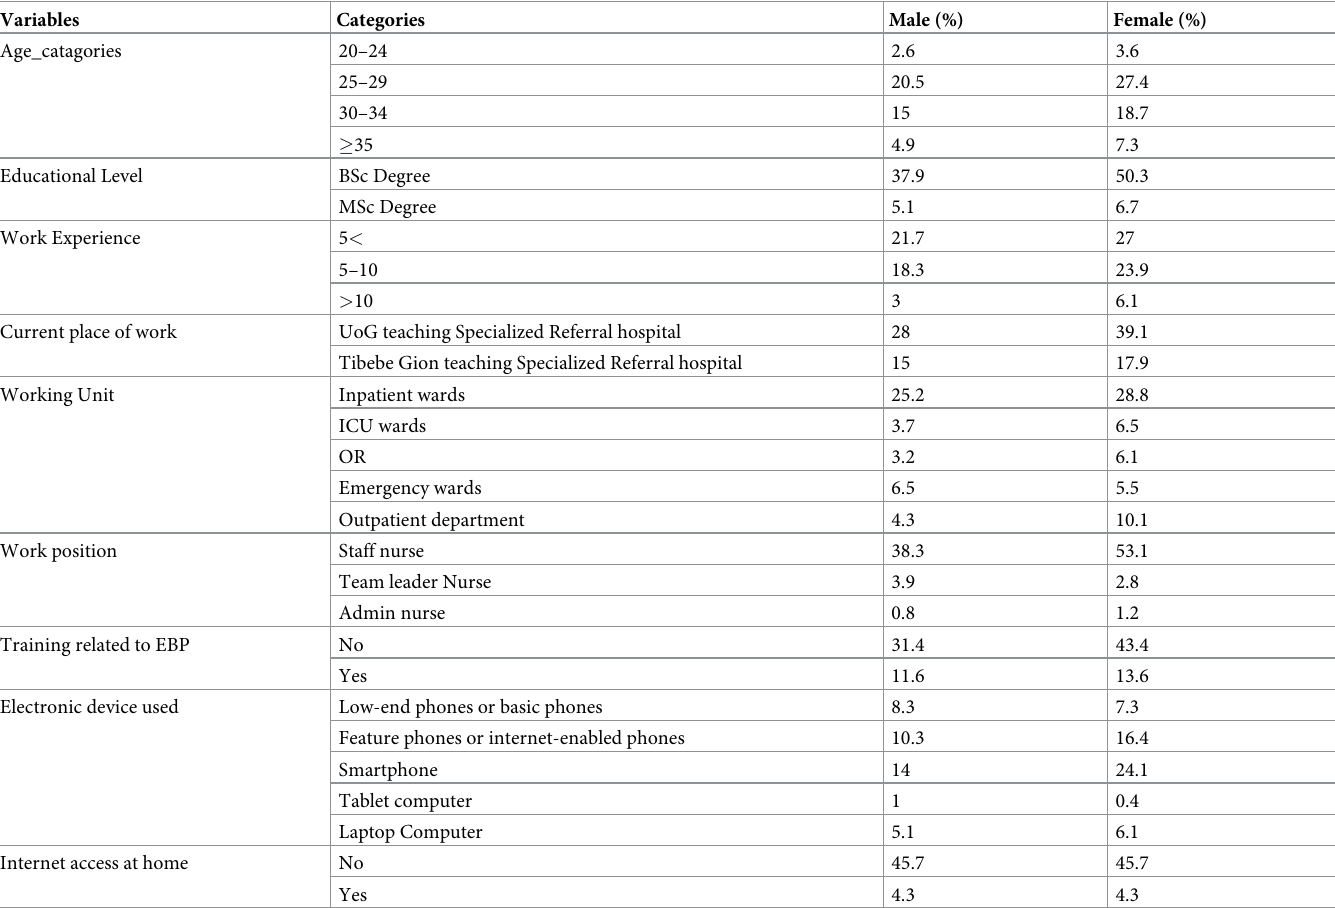
Table 2. Socio-demographic characteristics of nurses in the University of Gondar and Tibebe Gion teaching specialized hospitals, Ethiopia 2020 (n =